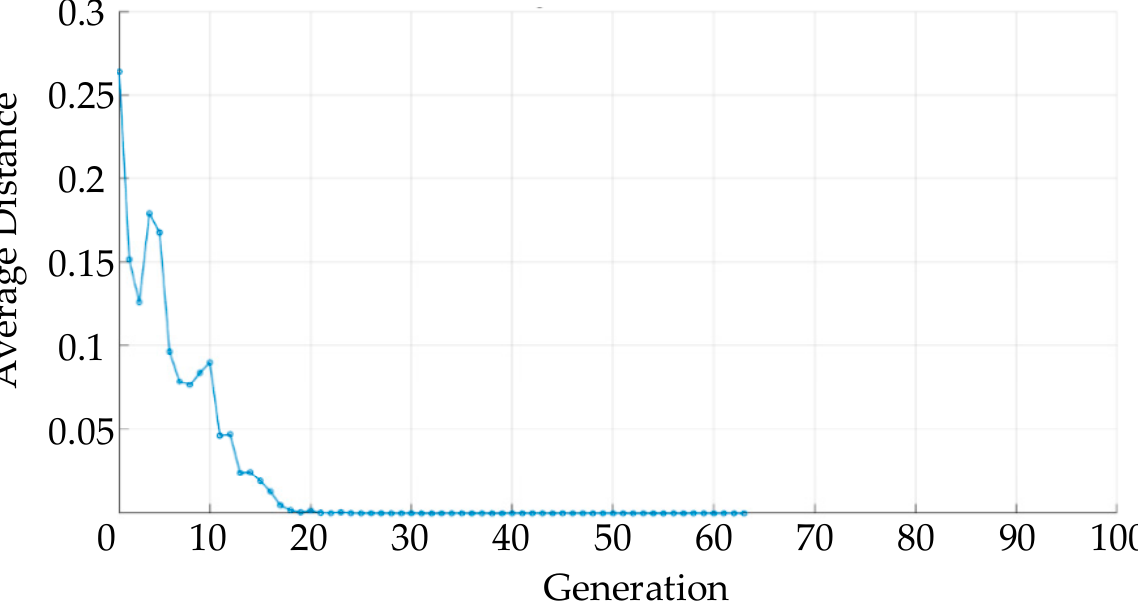
Figure 5. Average distance between individuals.